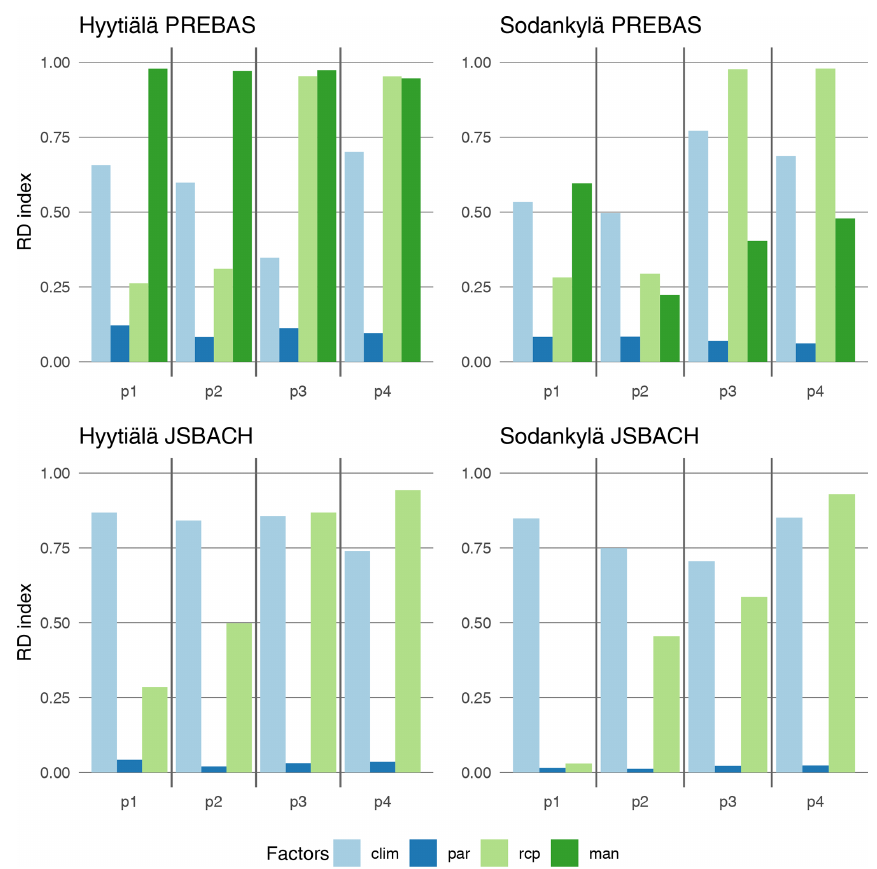
Figure 1. Redundancy indices for the different uncertainty factors, calculated using all ecosystem indicators using values from 1980–2009 (p1), 2010–2039 (p2), 2040–2069 (p3) and 2070-2099 (p4). Exact values are in the